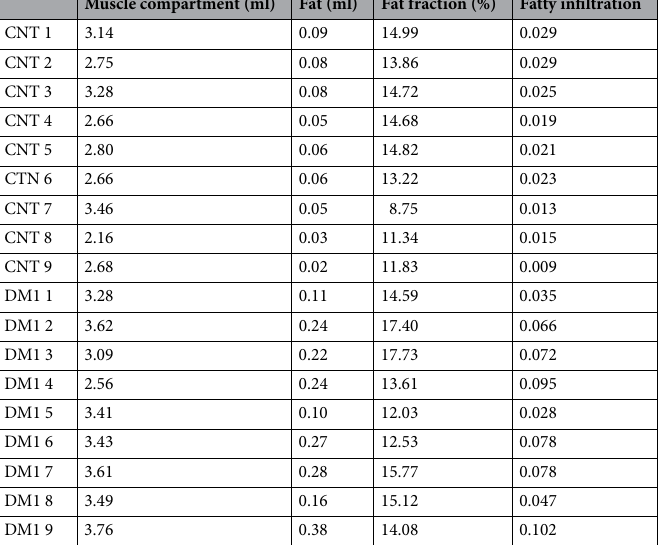
Muscle compartment (ml) Fat (ml) Fat fraction (%) Fatty